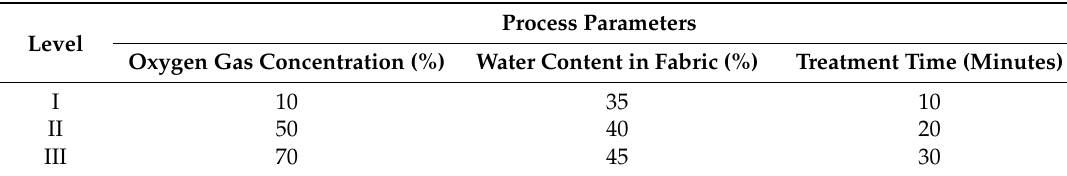
Table 2. Parameters and levels used in the orthogonal array testing strategy (OATS).